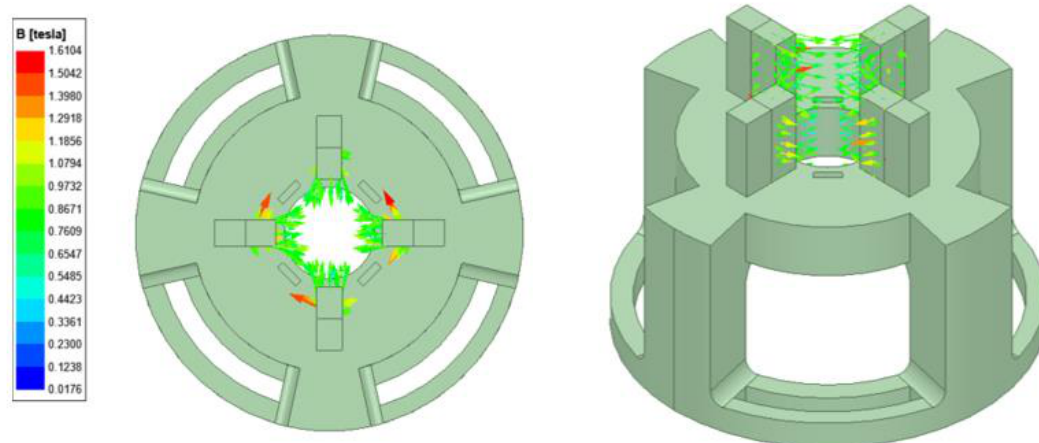
Figure 6. Magnetic vector contour for the magnetic field system by finite element analysis.